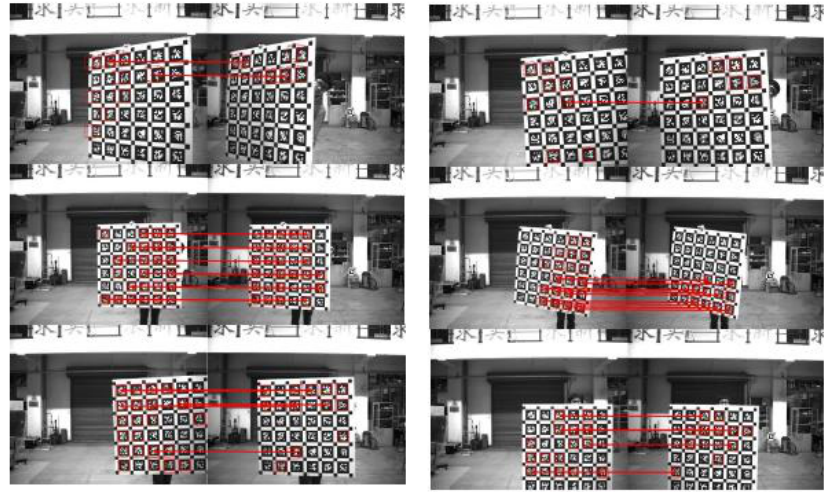
Figure 25. Extracted matching points and pose (1–6).